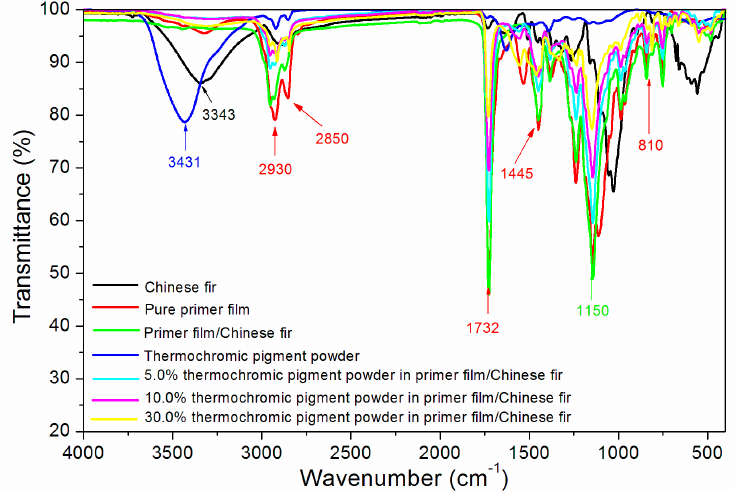
Figure 4. FTIR of di ff erent concentrations of thermochromic pigment powder in the waterborne primer film.